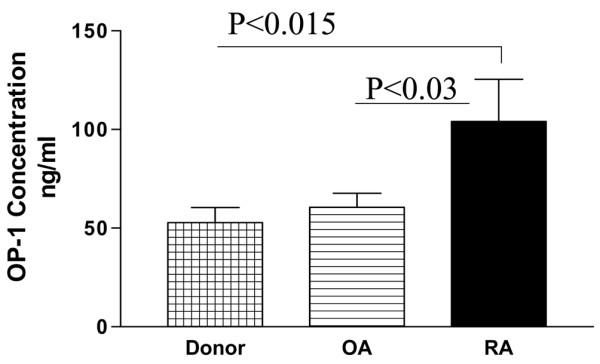
Content of osteogenic protein 1 protein in synovial fluid samples. The osteogenic protein 1 (OP-1) content of synovial fluid from asymptomatic donors (donor) and from osteoarthritis (OA) and rheumatoid arthritis (RA) patients detected by an OP-1 sandwich ELISA [19]. The data are presented as the mean ± standard error of the mean.